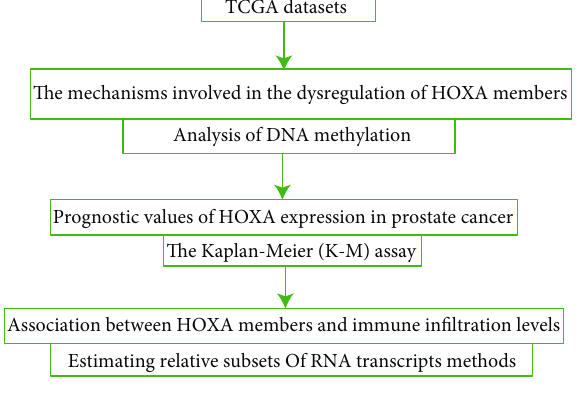
Figure 1: Study fl